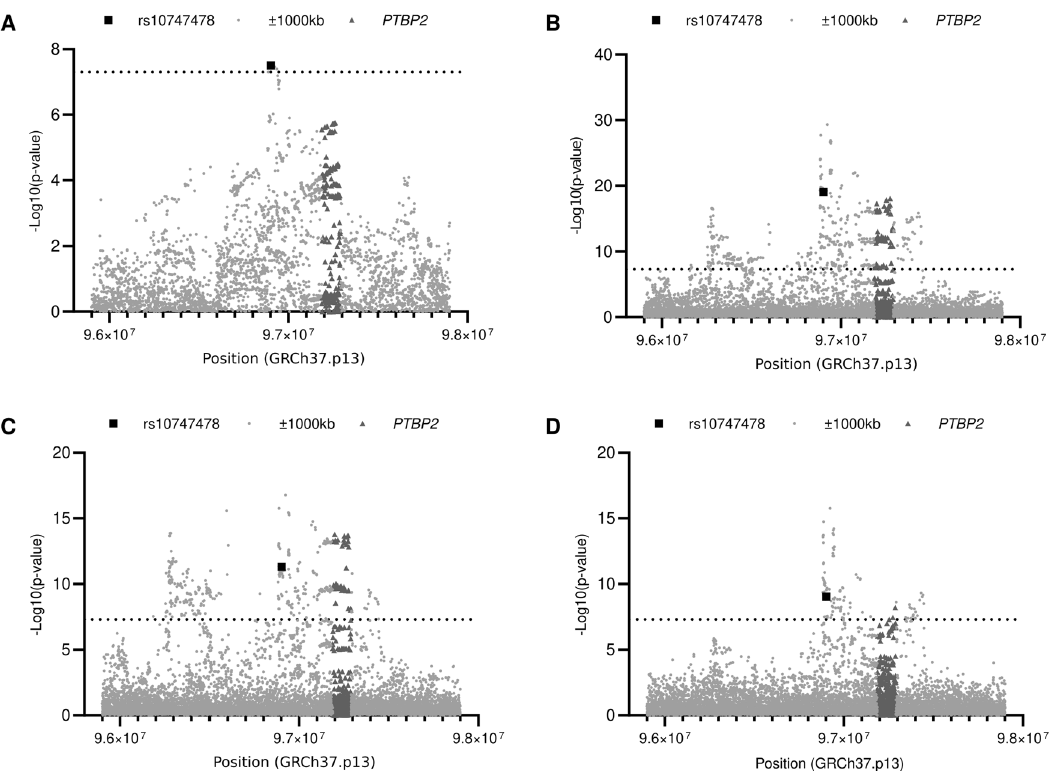
Fig. 2 Plots of the chromosomal location and p values of variants located near rs10747478 (±1000 kb) on BMI GWAS and AN GWAS data. Variants were extracted from Pulit et al. BMI GWAS [11] and Watson et al. AN GWAS [10]. A : AN, B : BMI (combined sexes), C : BMI males, D : BMI females. The − log10( p value) for the association are shown on the y-axis and the chromosomal locations are ordered on the x-axis. The variants which surpassed the dashed line are genome-wide signi fi cant. Light gray dots indicate ±1000 kb genomic region of rs10747478, black square pointed to SNP rs10747478, and variants located in the PTBP2 genomic region plotted with dark gray